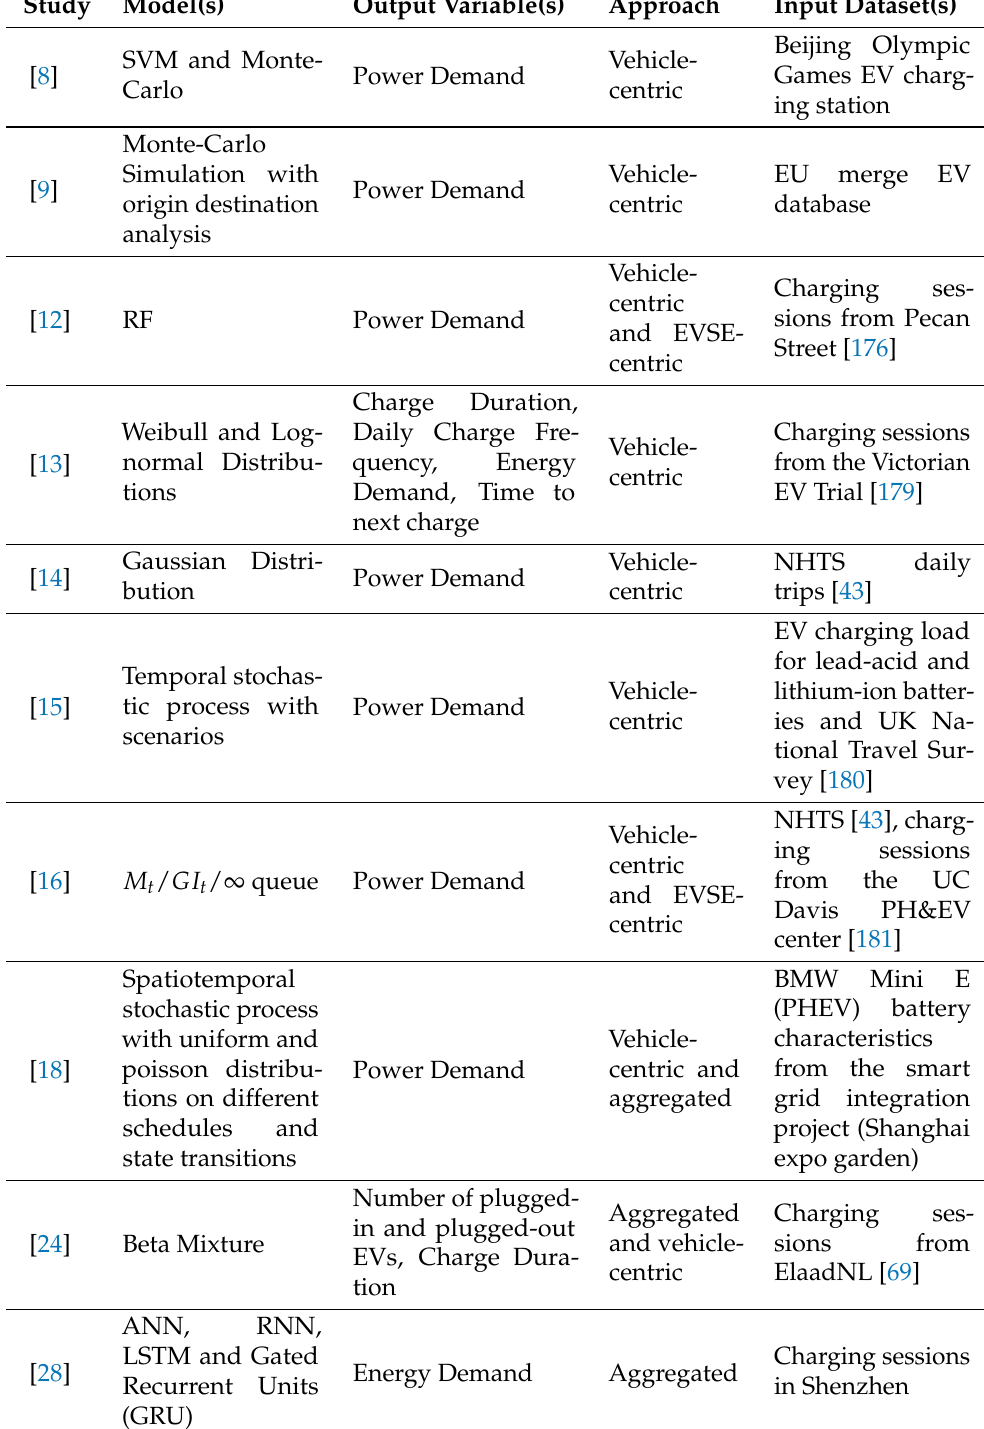
Table A1. Exhaustive list of models presented in Section 4 with the input dataset(s) used (if appli- cable), the approach taken (Aggregated, Vehicle-centric or EVSE-centric) and the output variable(s) modelled. For the input datasets, the data repositories or data reports are provided as references when they were clearly made available by the authors of the